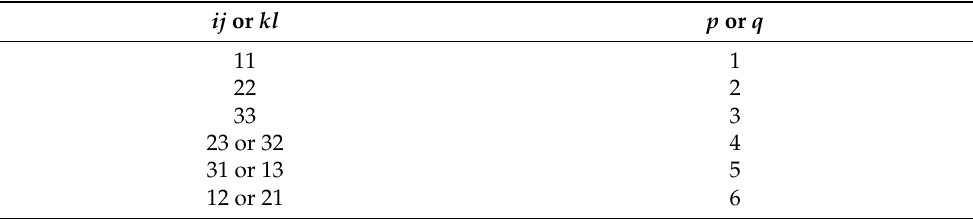
Table 1. Extended tensor notation and compressed matrix notation. ij or kl p or